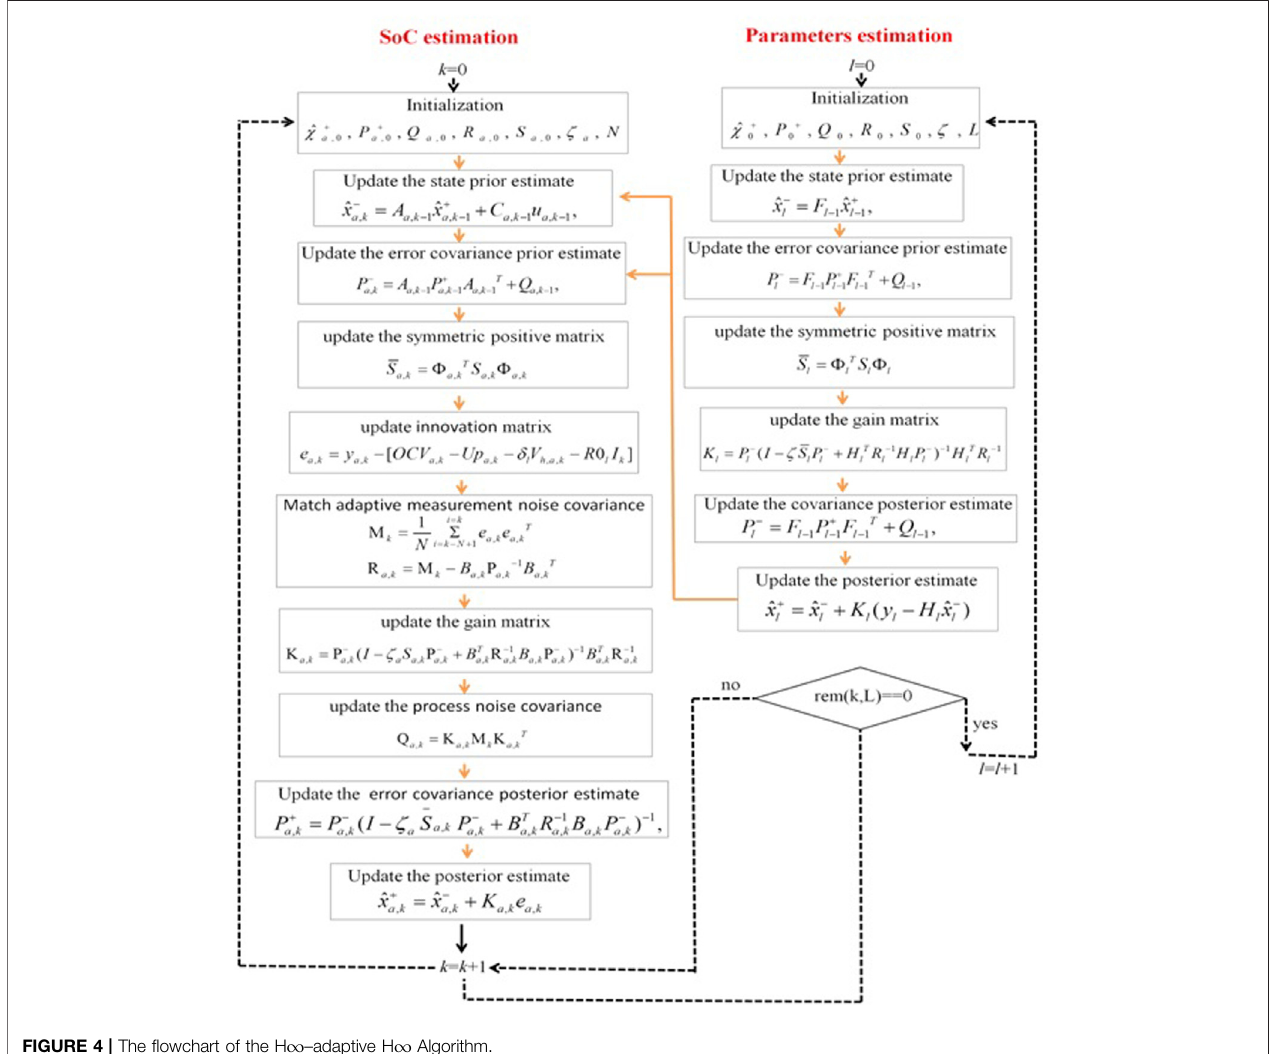
FIGURE 4 | The fl owchart of the H ∞ – adaptive H ∞